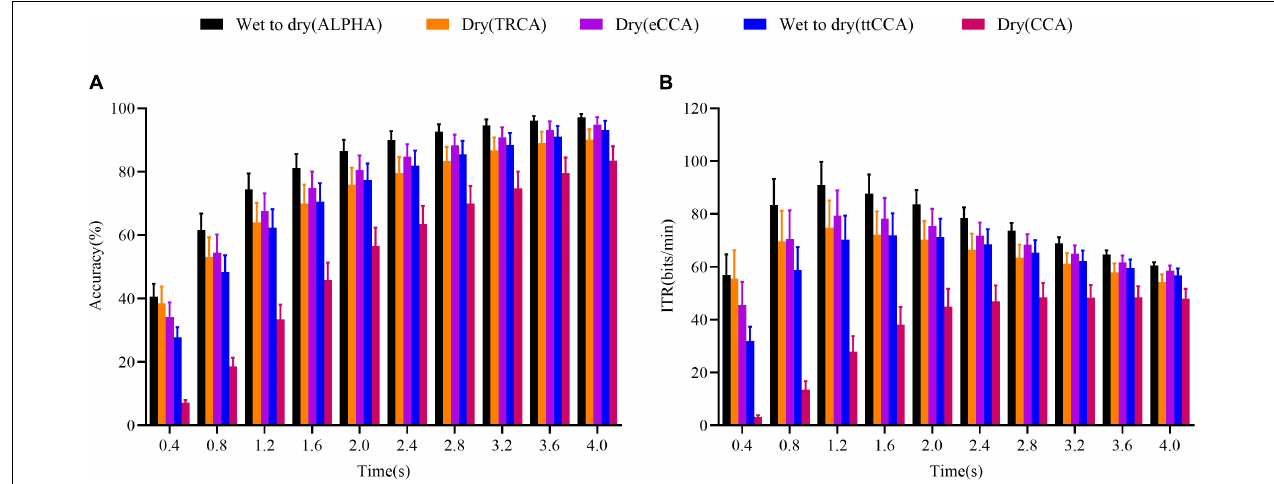
FIGURE 4 | Comparison of the accuracy and ITR results of the five methods in the cross-day wet-to-dry transfer experiment. (A) Accuracy. (B) ITR value. The horizontal axis represents the data length; the error bars indicate standard